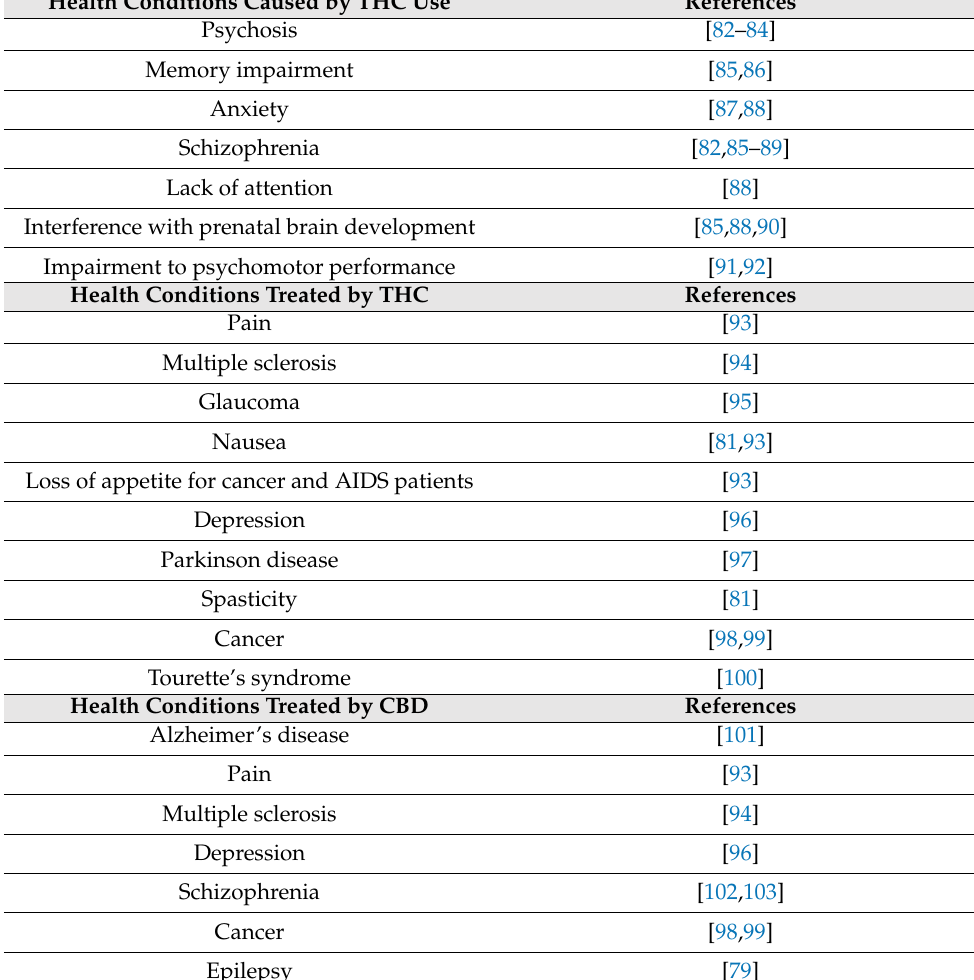
Table 1. Harmful and beneficial effects of phytocannabinoid